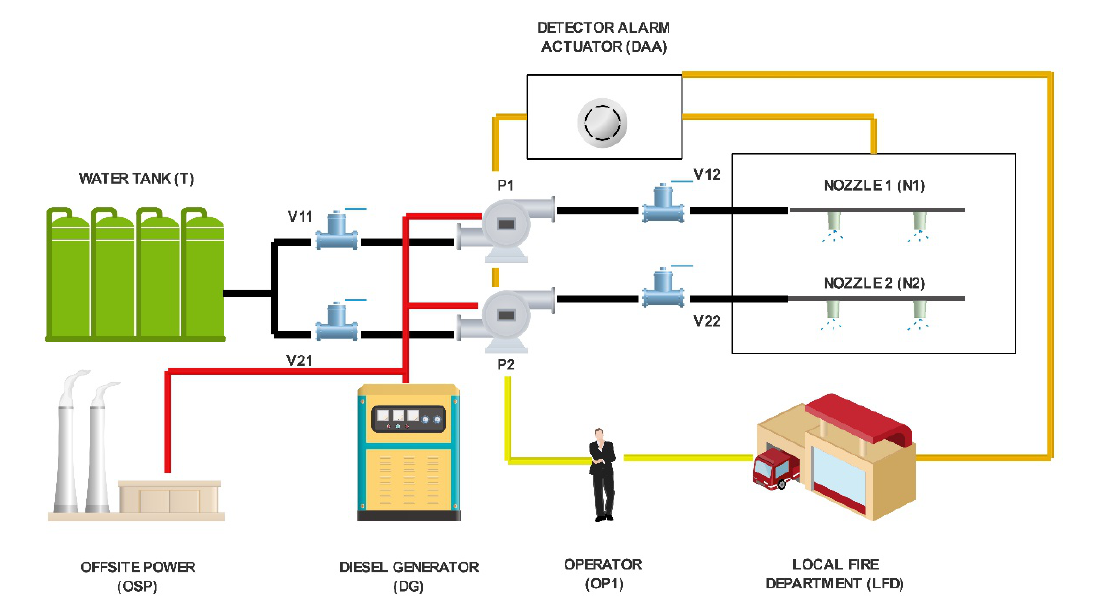
Figure 4. Automatic fire sprinkler system